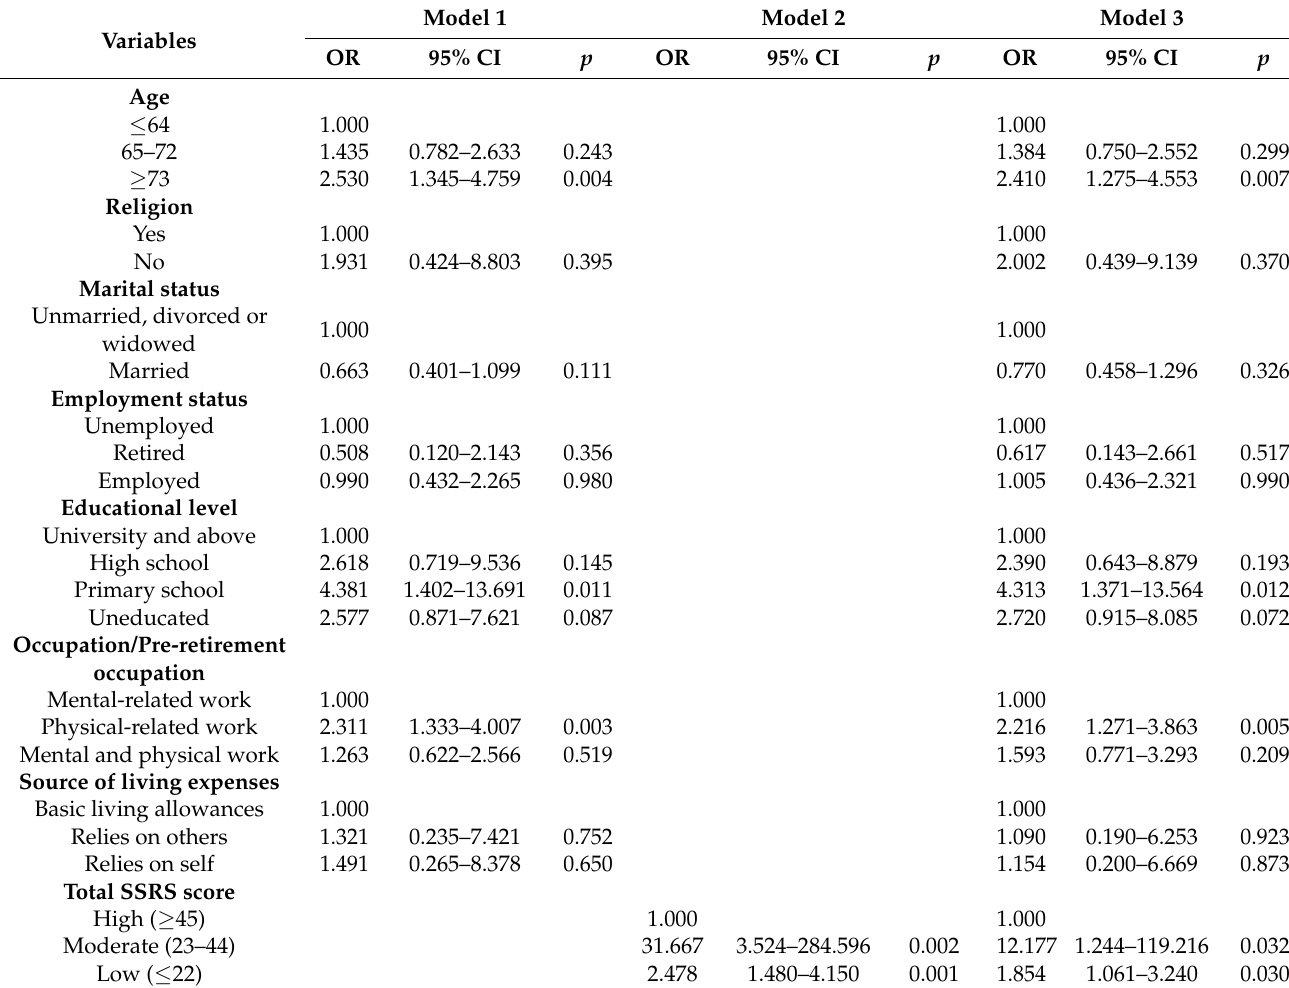
Table 2. Logisticregressionanalysisontherelationshipbetweensocio-demographicfactors,socialsupportandcognitiveimpairment.